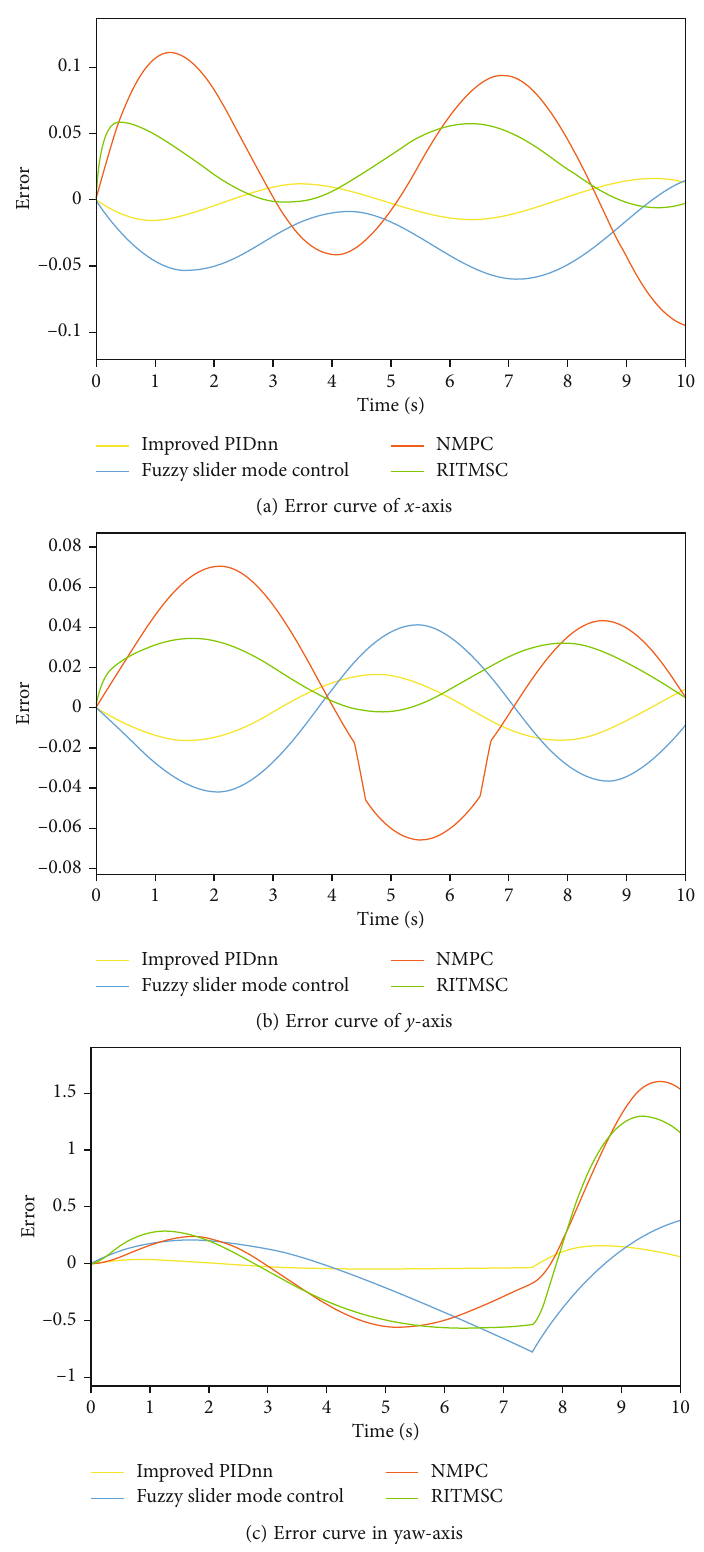
Figure 14: Motion trajectory comparison of advanced algorithms